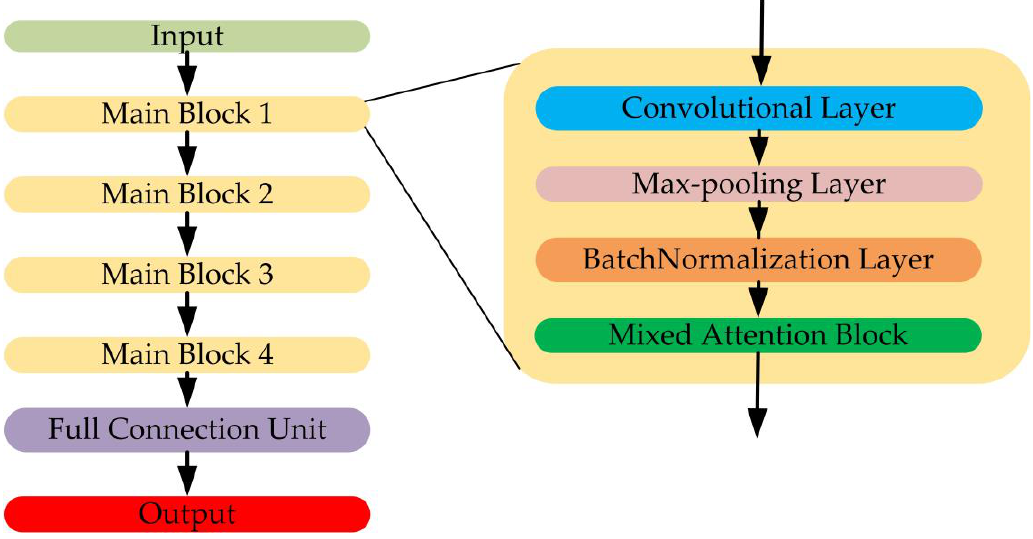
Figure 2. The structure of mixed attention convolutional neural network (MA-CNN).